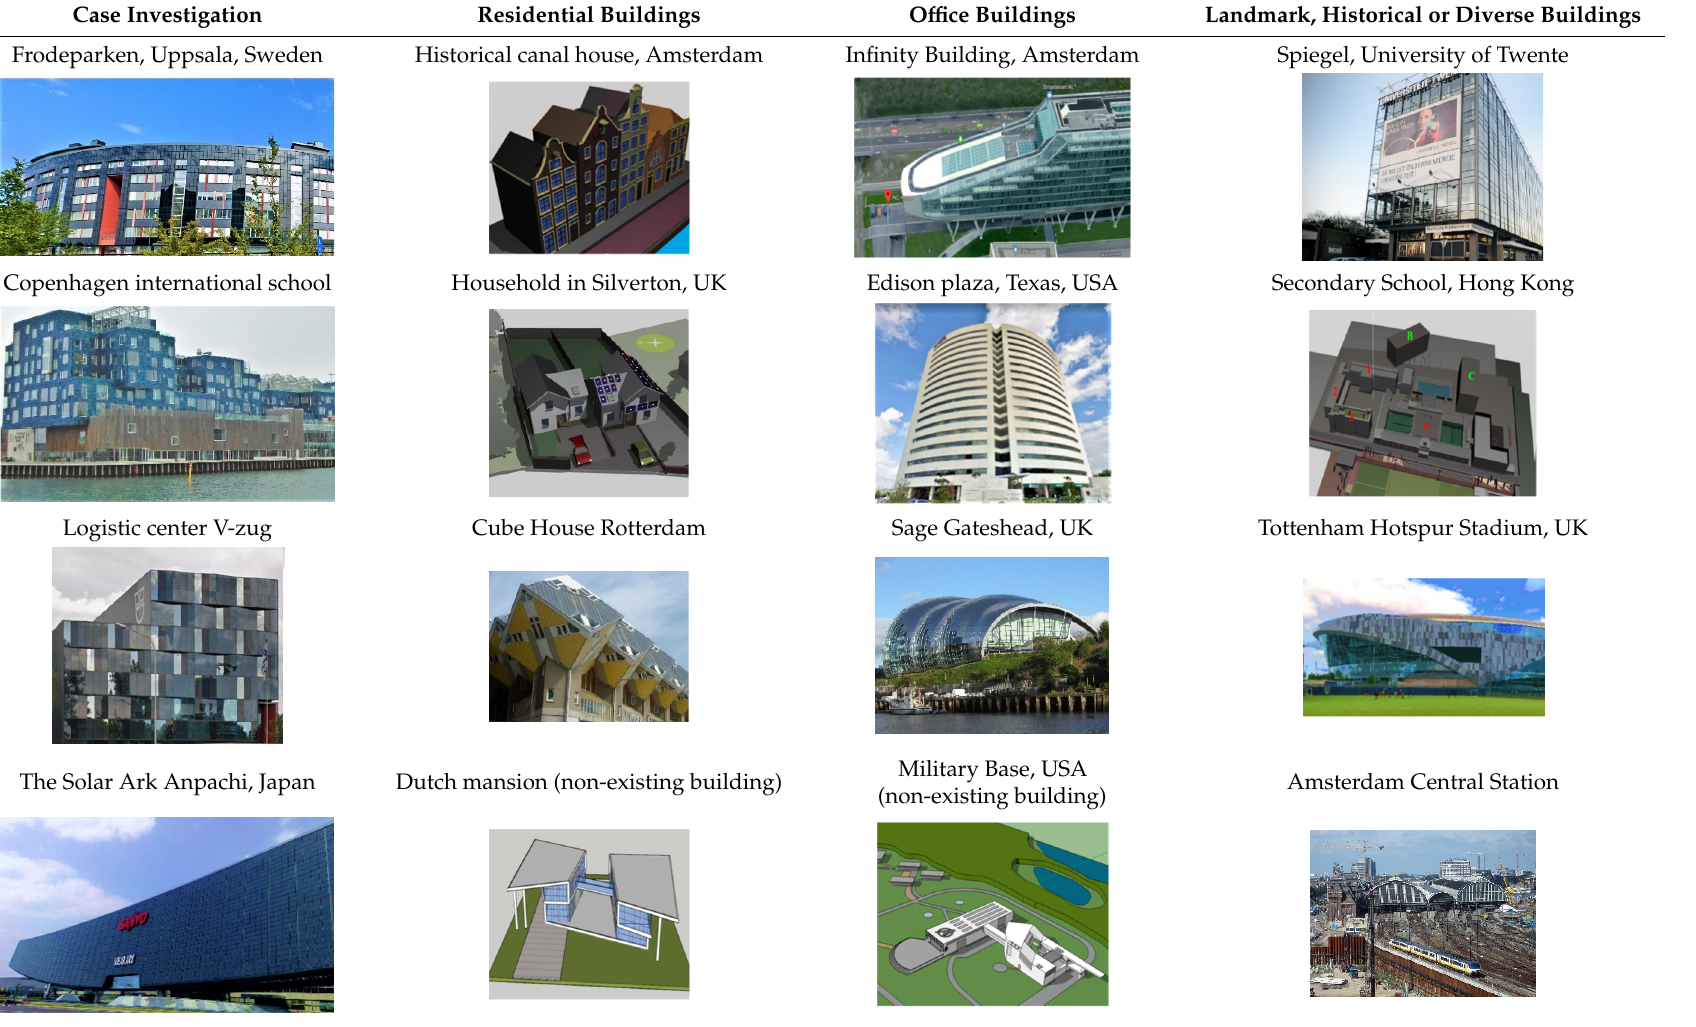
Table 1. Buildings selected per group of students for building integrated photovoltaic (BIPV) projects (image references, respectively: [27–49]). Case